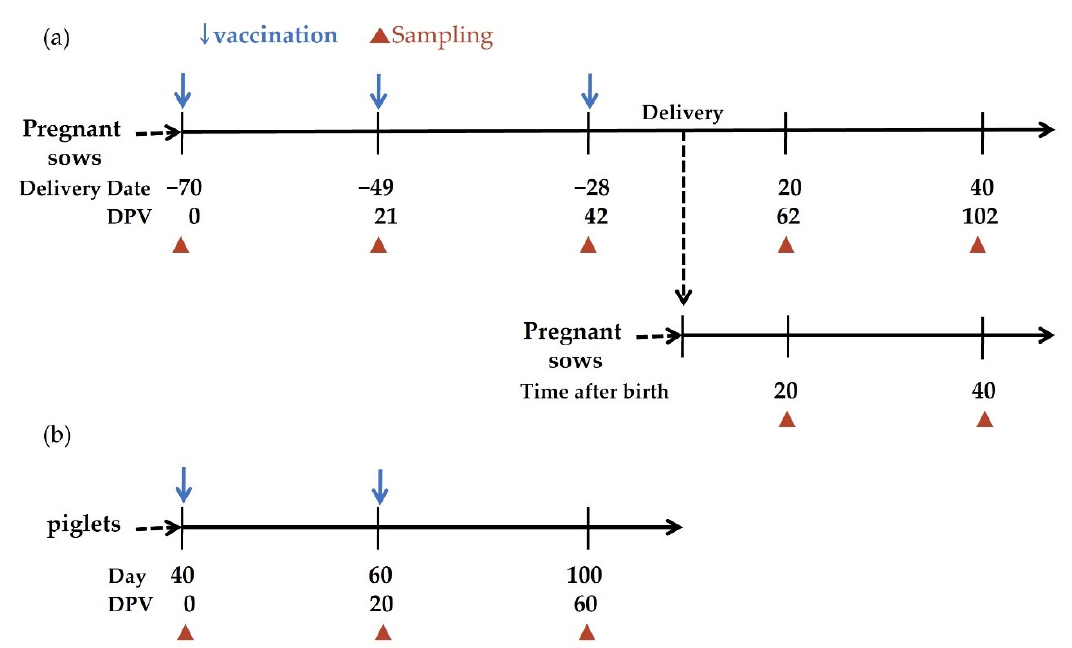
Figure 1. The schematic presentation of Immunization protocols in Jeju Island. ( a ) The timing of blood collection, vaccination, and delivery from pregnant sows and newborn piglets was presented. ( b ) The timing of blood collection and vaccination from CSF-free piglets was